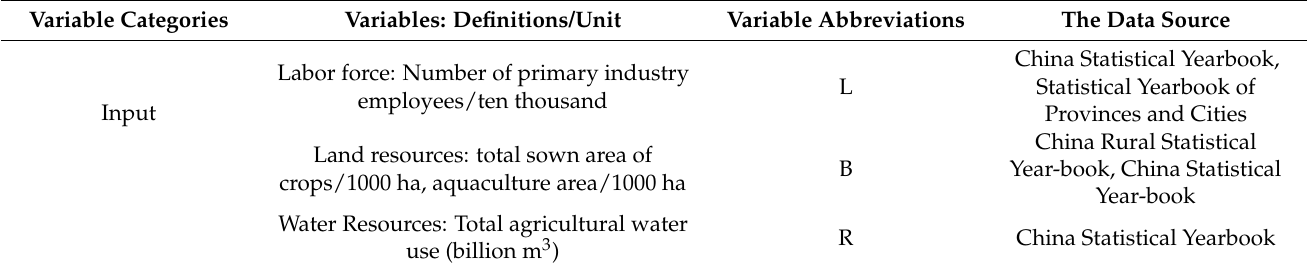
Table 2. Connotation of input and output